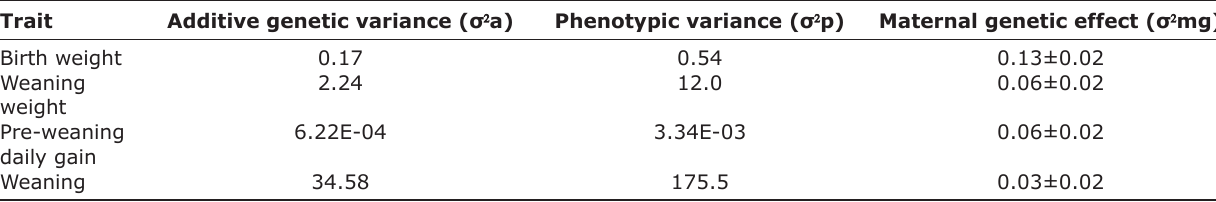
Table-3: Additive genetic variance (σ 2 a), phenotypic variance (σ 2 p), and maternal genetic effect (σ 2 mg) of growth traits studied in Awassi lambs. Trait